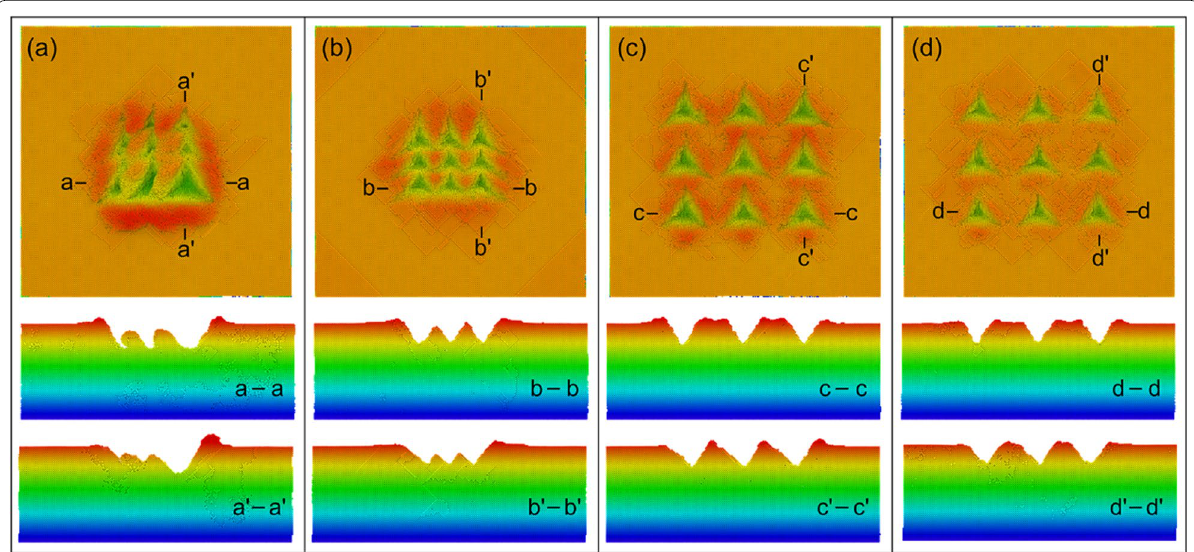
5 nm, b indenter array with feed =